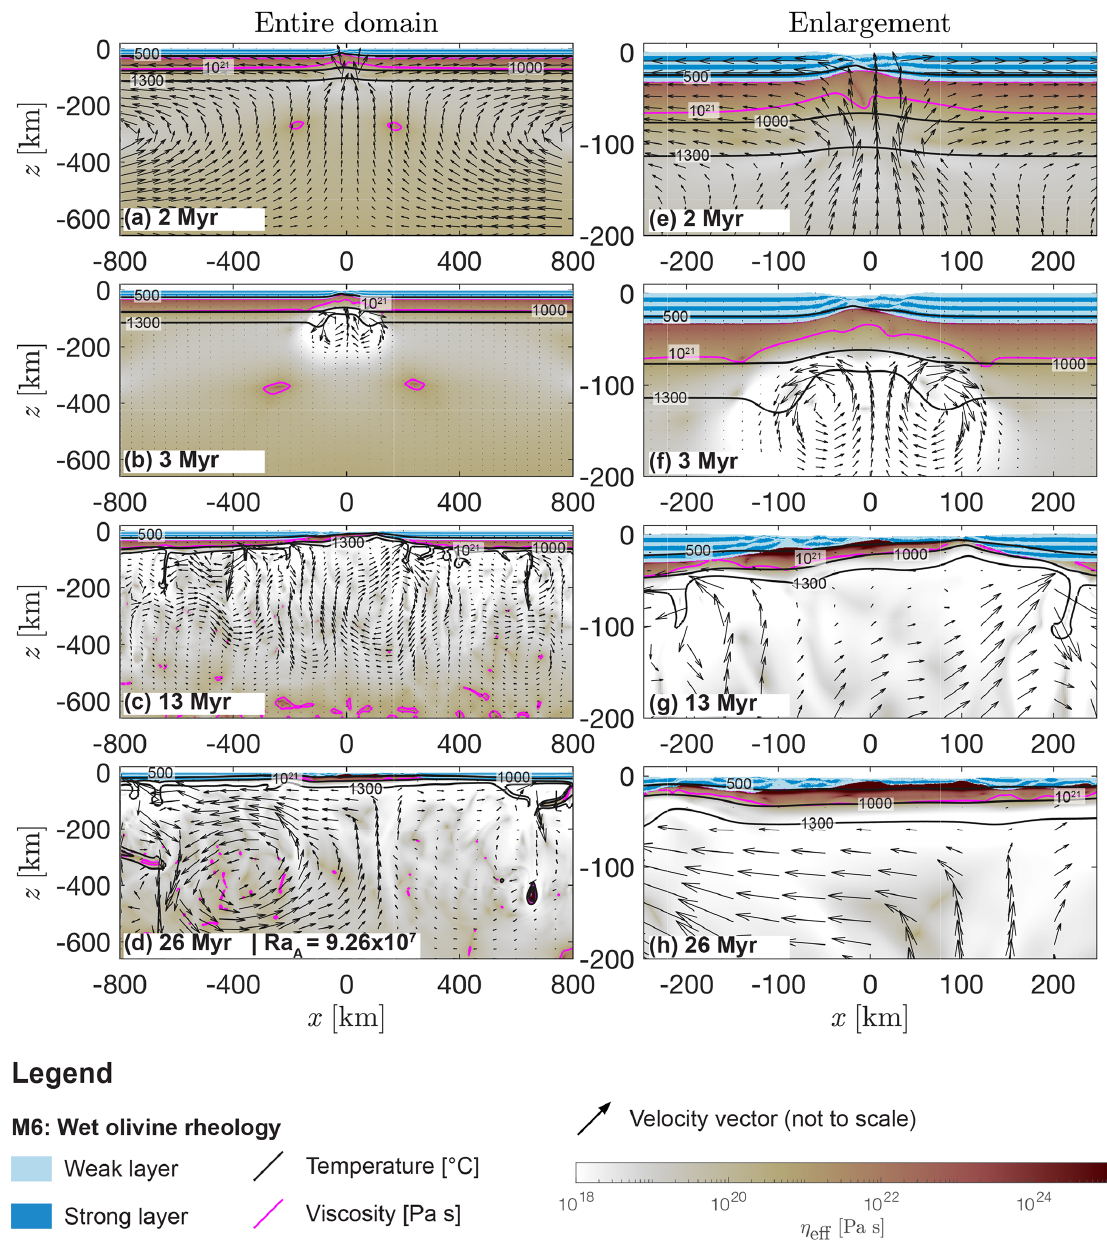
Figure 4. Evolution of model M6 at (a, e) 2Myr, (b, f) 3Myr, (c, g) 13Myr and (d, h) 26Myr. Blue indicates mechanically weak (light) and strong (dark) crustal units. White to red colours show the effective viscosity field calculated by the numerical algorithm. Black lines show the level of the 500, 1000 and 1300 ◦ C isotherm, and the magenta line shows the level of the 10 21 Pas viscosity isopleth. This contour line represents the mechanical boundary between the mantle lithosphere and the convecting upper mantle. Arrows represent velocity vectors, and the length of the arrows is not to